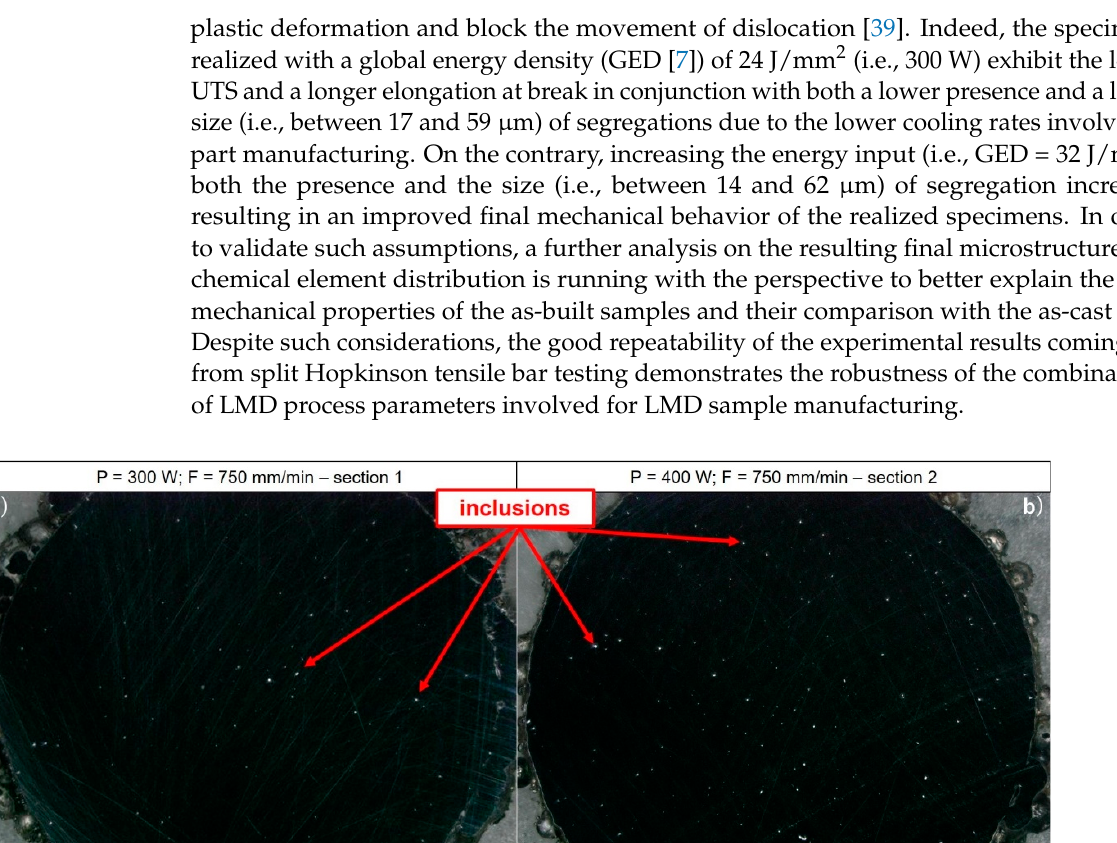
18 of 23 Figure 13. Mechanical tensile properties of the realized specimens: ( a ) at 200/s; ( b ) at 800/s. The reason for the higher mechanical strength and the lower elongation at break detected for the as-built specimens realized at 400 W can be explained by an increased presence of inclusions compared to the samples built at 300 W, which appear as bright areas in Figure 14. As stated by several works [29,30,40], the microstructure of Inconel 718 parts produced by LMD can exhibit both the presence of inclusions of oxides and the formation of intermetallic segregations due to the high thermal gradients involved during the deposition process. Moreover, the employment of high energy inputs in LMD have been demonstrated to facilitate the formation and the growth of Laves phase and carbides into the as-deposited Inconel 718 microstructure due to the low cooling rates involved [13,41,42]. The Laves phase is a hard and brittle intermetallic compound and, in conjunction with carbides, affects the final performance of Inconel 718. Several authors have demonstrated the influence of both the shape and the distribution of the Laves phase and carbides on the final properties of Inconel 718 parts, demonstrating that an excessive presence of intermetallic compounds decreases the final mechanical properties of the as- built parts, lowering both the material strength and the elongation at break and inducing a more brittle behavior of as-built specimens compared to wrought material. Nevertheless, other authors have proved that a controlled presence of the Laves phases